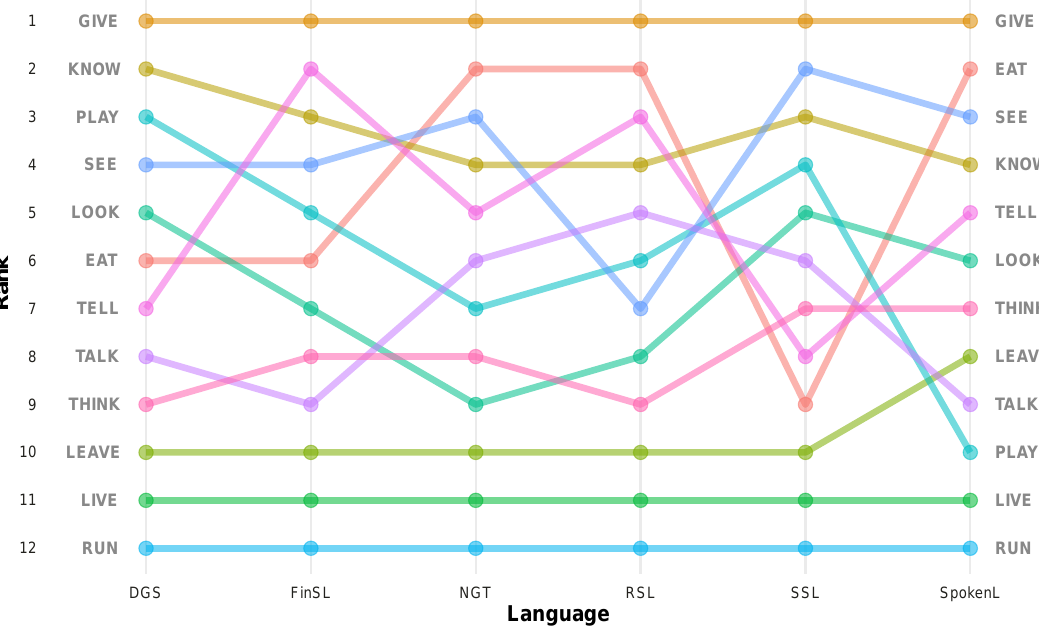
Figure 5: The rank of the 12 ValPaL meanings in the five sign languages in terms of their transitivity proportions and the spoken languages from Haspelmath (2015). Locative arguments are excluded for the sign